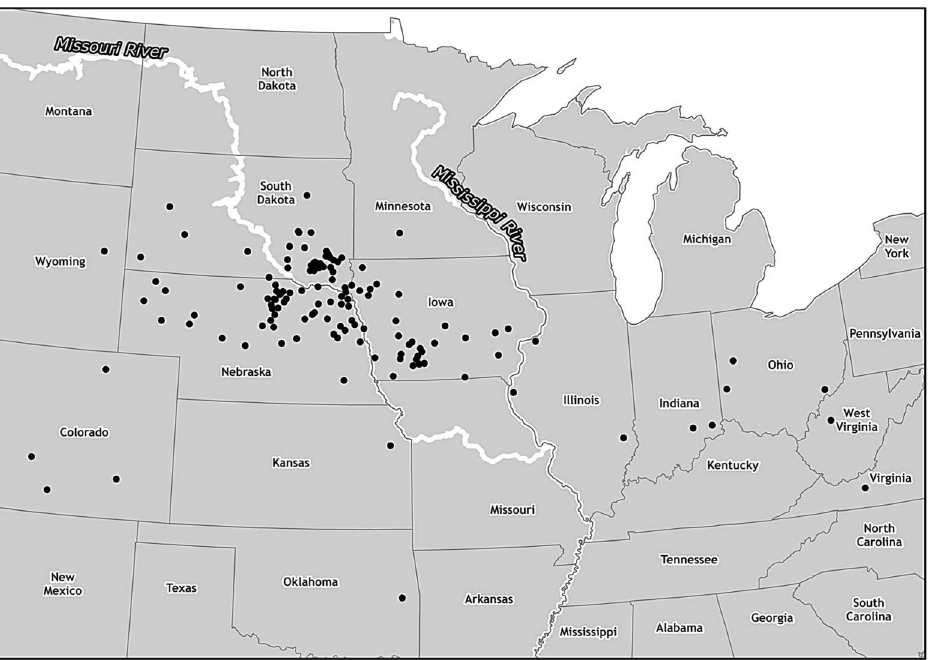
Fig 1. Density of bovine EHD cases during 2012 outbreak. To protect the confidentiality of individual producers, each symbol represents a bovine case of EHD randomly placed in the county in which it occurred.